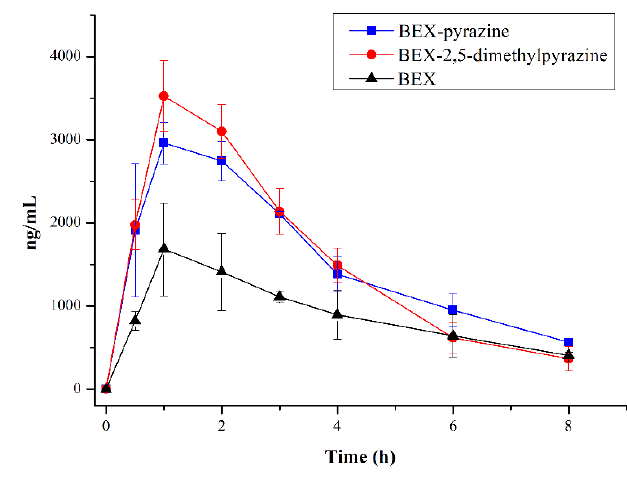
Figure 11. The PK profiles of BEX and cocrystals in rats. Table 2. Pharmacokinetic parameters of BEX and cocrystals in rats.